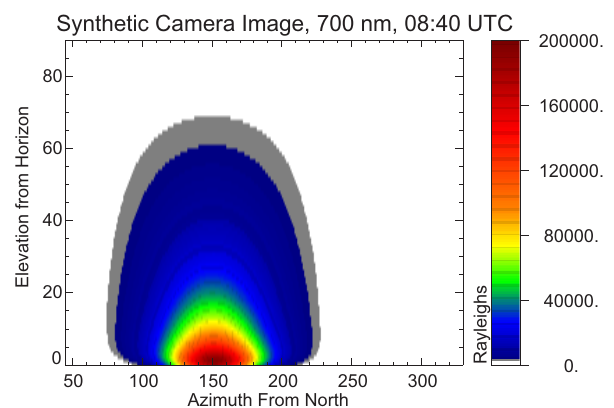
Fig. 10. A snapshot of the modelled sky intensities at 700nm at 08:40 UT. This figure is a wide angle snapshot comparable with the photograph shown in Fig. 1.